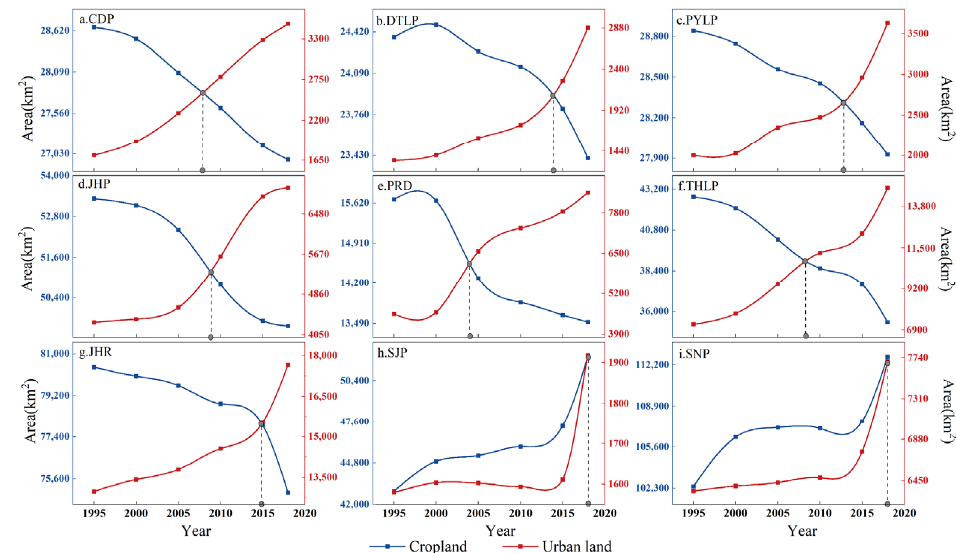
Figure 3. Land-use type change at the individual level, 1995–2018.